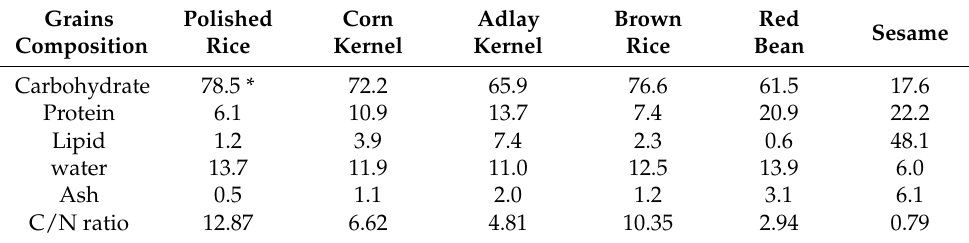
Table 1. The composition and C/N ratio of grains in this study.